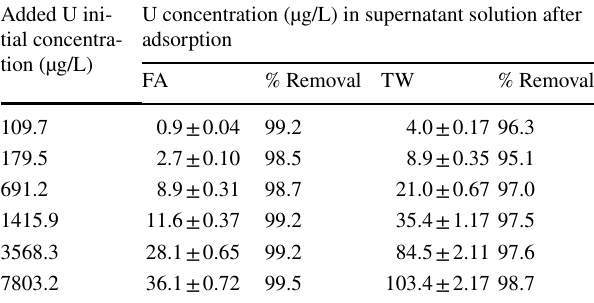
Table 3 U concentration left in supernatant for different U initial con- centrations with 1 g of FA and TW at pH 6 Added U ini- tial concentra- tion (µg/L)